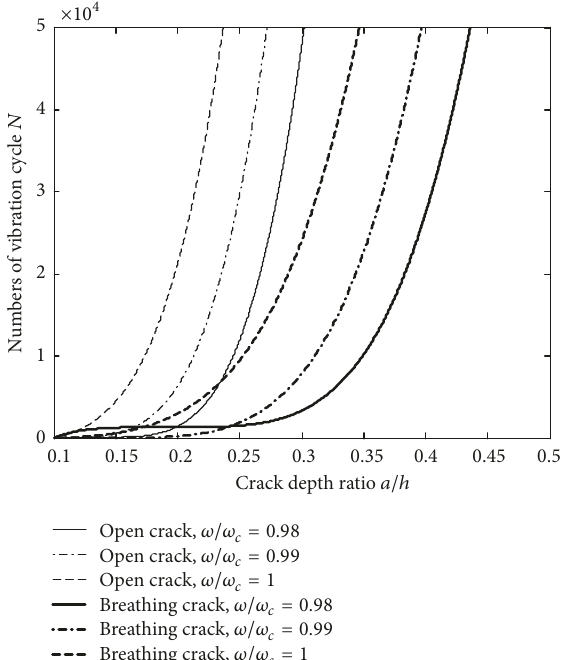
Figure 13: Crack depth with vibration cycles for different frequency ( 𝜇 = 0 ).